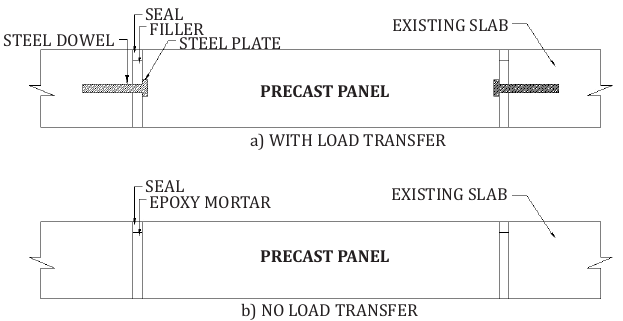
Figure 5. Types of joints used at M59 Livingston